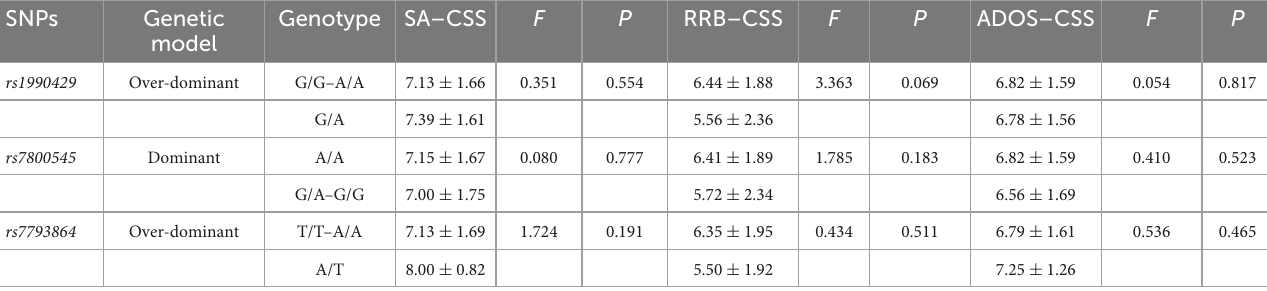
TABLE 8 The genotype association of KCND2 with ADOS–CSS adjusted by age, sex, and IQ.